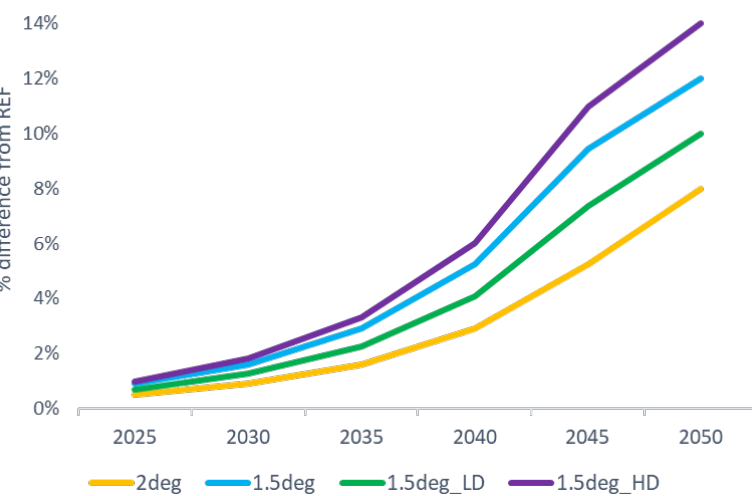
Figure 11. Cost differences in the shipping sector between the scenarios.